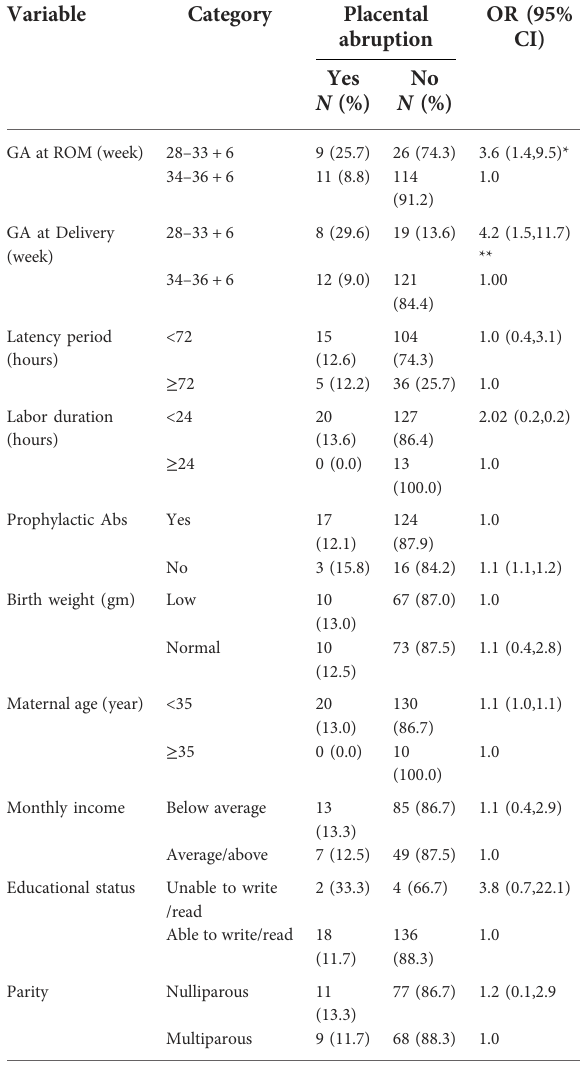
TABLE 8 Factors determining placental abruption among pregnant women with preterm premature rupture of membrane.